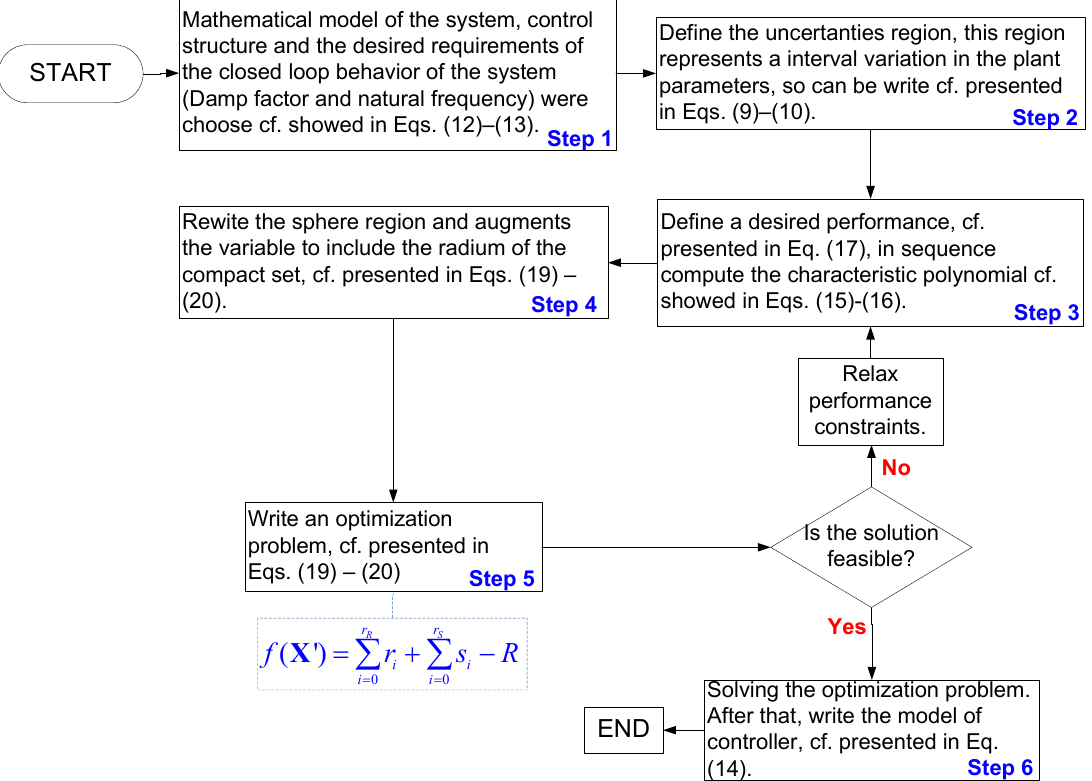
Figure 5. Flowchart of control design methodology based on Chebyshev